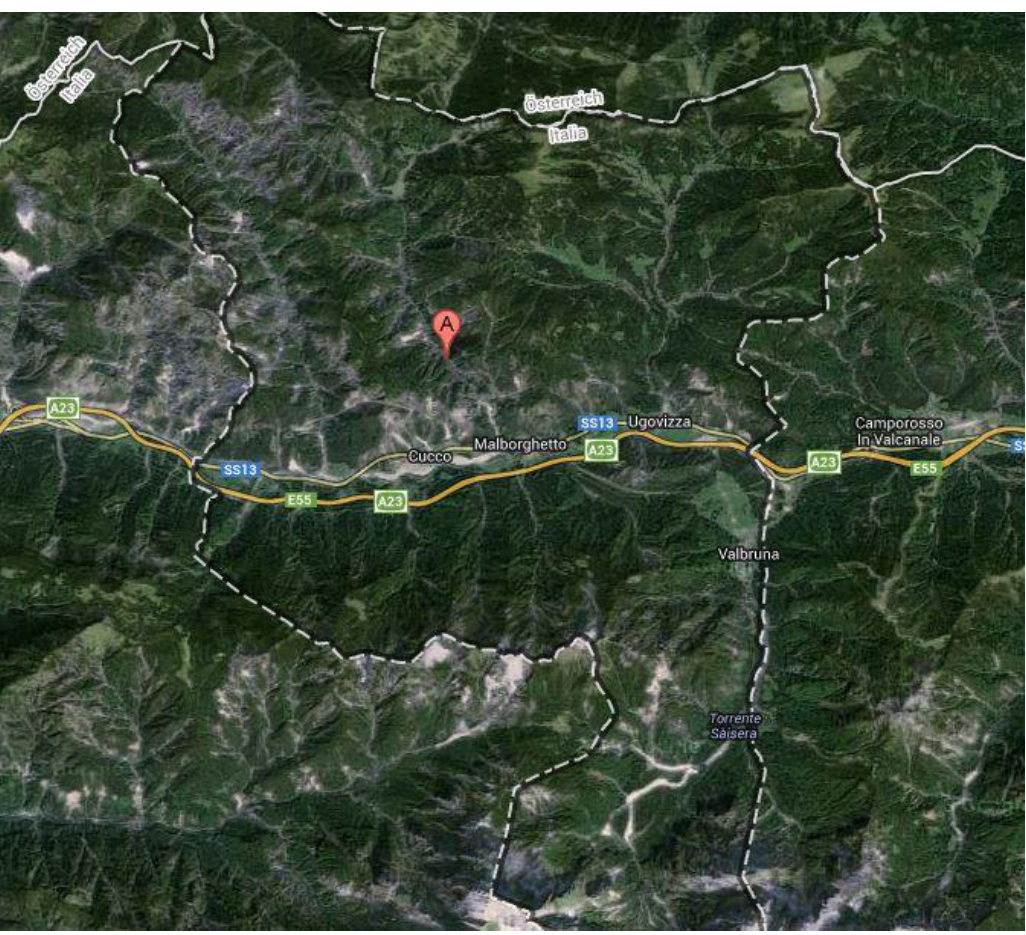
Figure 7. Malborghetto Valbruna municipality (Source: Google Map).